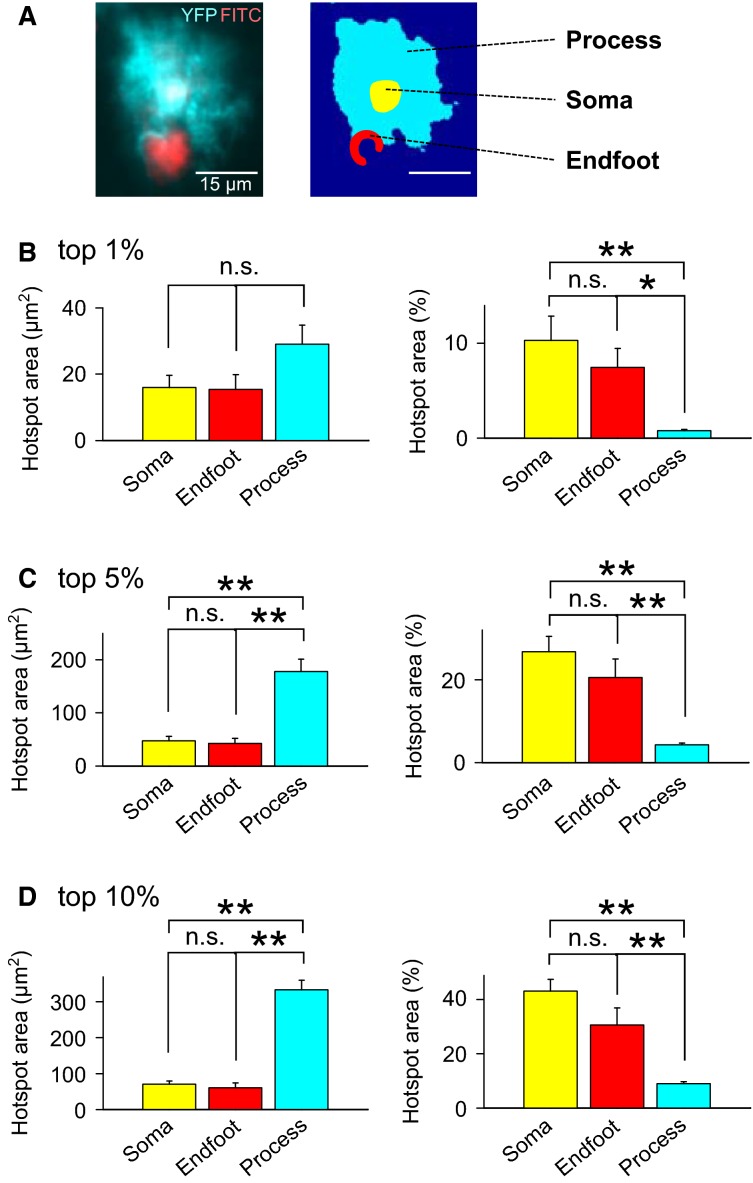
Subcellular localization of calcium hotspots. (A), Representative two-photon image of an astrocyte (YFP, cyan) and FITC-dextran-injected blood vessels (FITC, red) in the layer 2/3 of the primary visual cortex (left). The cell was divided into three regions, soma, process, and endfoot (right). (B–D), Pixels with Z scores in the top 1% (B), 5% (C), and 10% (D) in their entire distributions were defined as “hotpixels”. The total areas (left) and the ratios (right) of hotpixels to the total area in the three zones are plotted. Error bars are SEMs of 33 cells (soma), 22 cells (endfoot), and 38 cells (process) from 10 videos. *P < 0.05, **P < 0.01, Tukey’s test after one-way ANOVA.